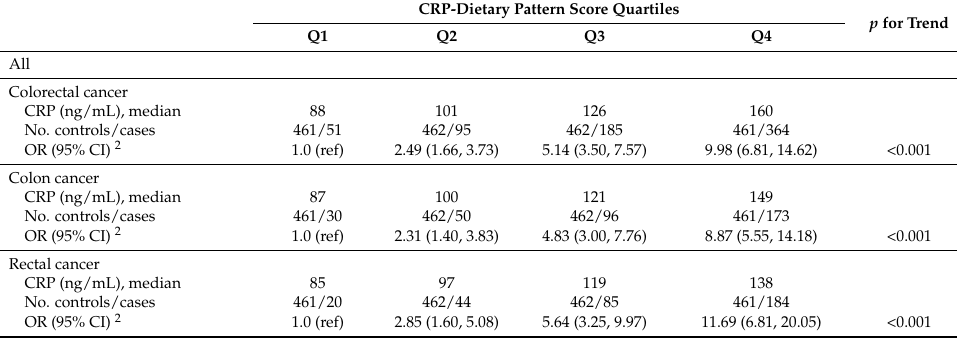
Table 4. Association between the CRP-dietary pattern score and colorectal cancer risk.